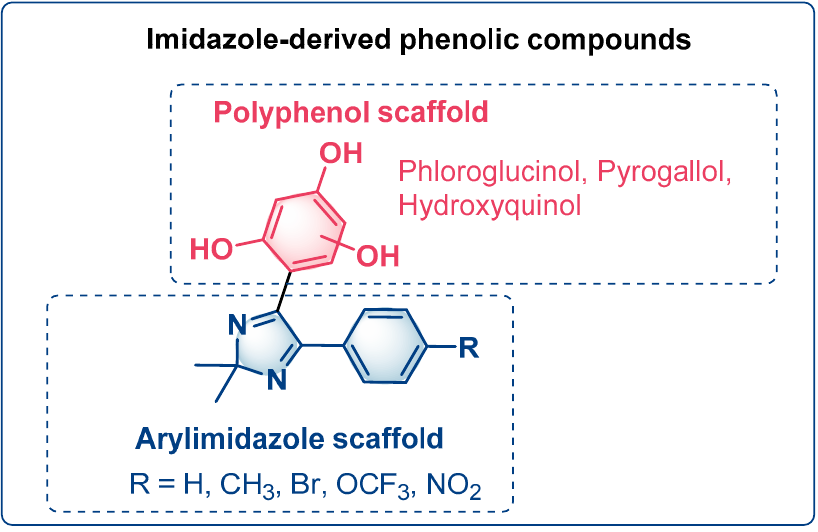
Figure 3. Imidazole-derived phenolic